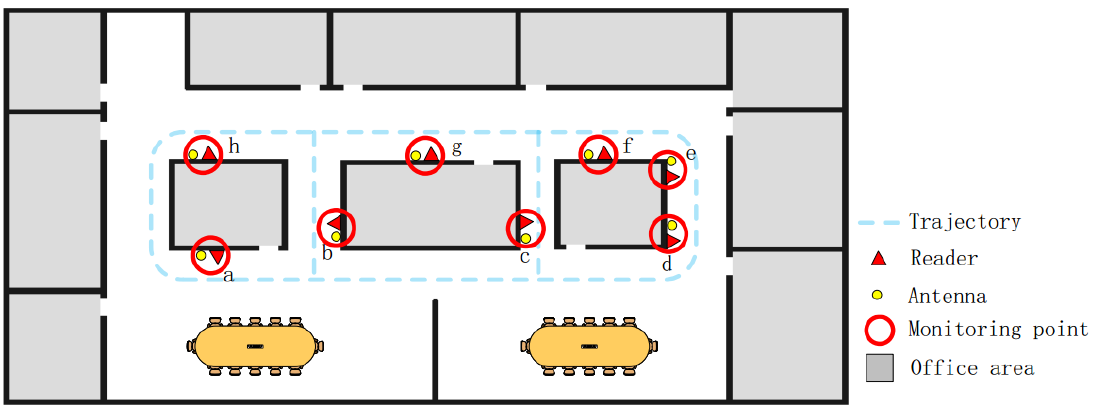
Figure 4. Vertical view of experimental area.